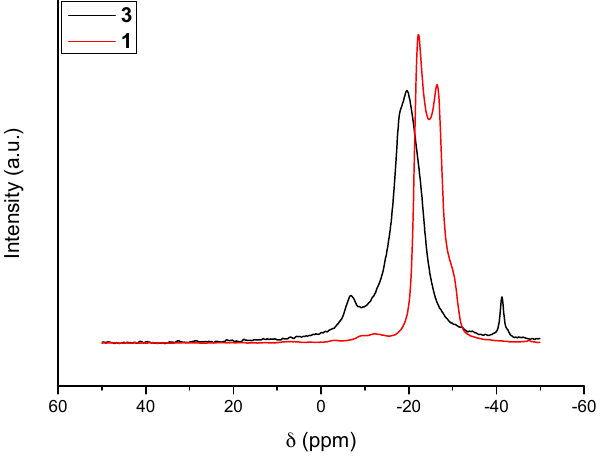
Figure 1. 11 B MAS NMR spectra of 3 . For comparison the spectrum of N 2 H 4 BH 3 ( 1 ) is shown.